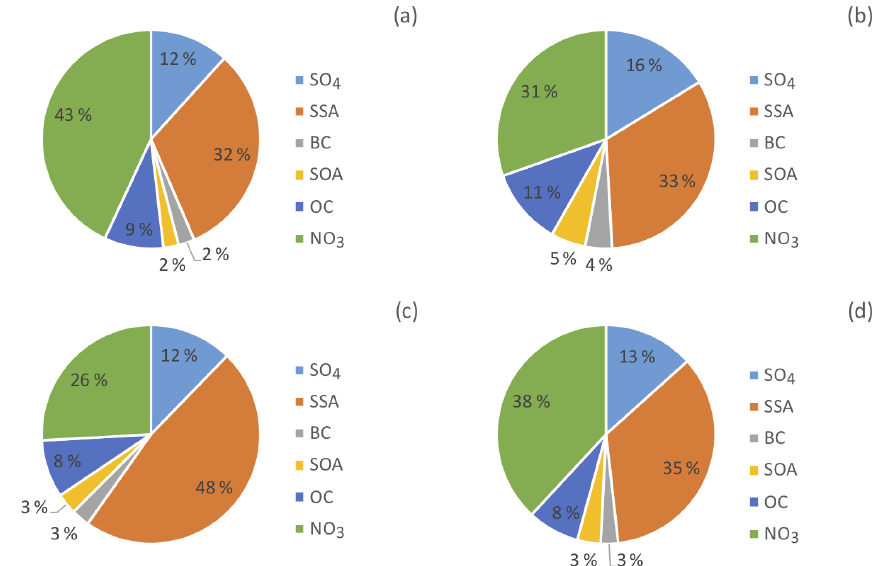
Figure 4. Simulated surface PM 2 . 5 chemical composition over (a) Denmark, (b) Finland, (c) Norway and (d) Sweden.